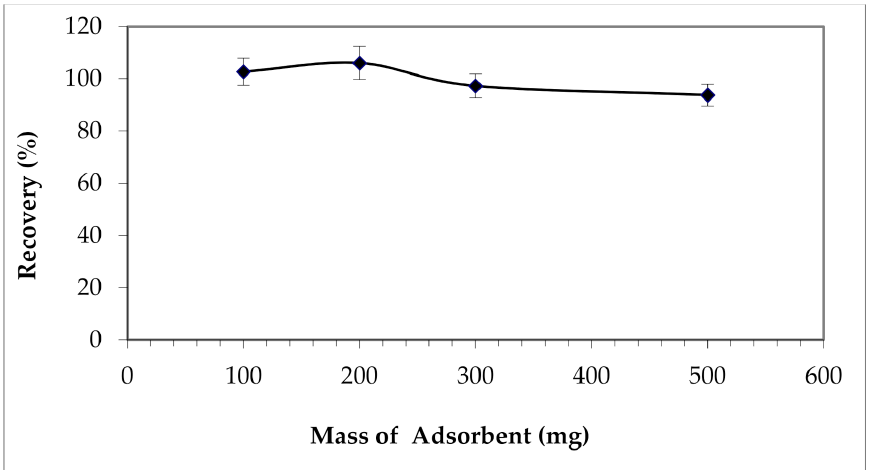
Figure 12. Effect of the mass of the adsorbent on Cu (II)